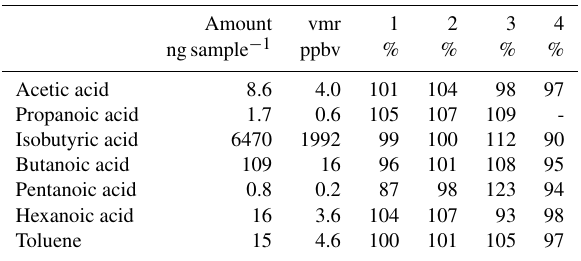
Table 2. Recoveries (%) from the inlets together with amounts and mixing ratios (vmr) used in the